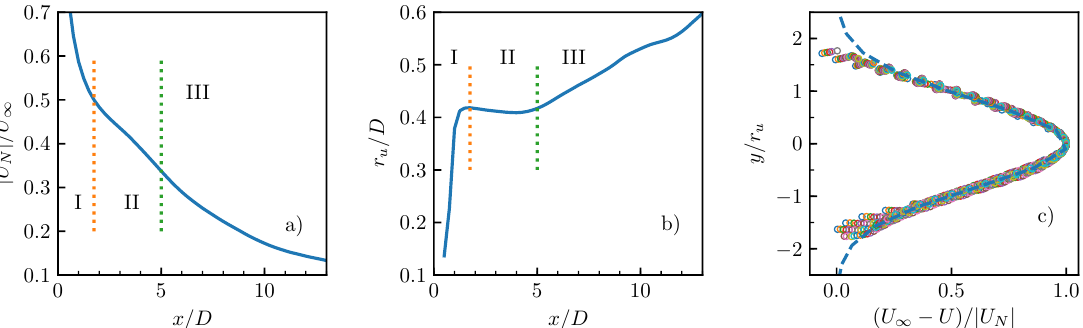
Figure 9. The self-similarity of the mean velocity deficit. The characteristic scales of velocity deficit and wake width are shown in ( a , b ), respectively, where the dotted lines are the boundaries of the three stages of wake development. The normalized spanwise profile of mean velocity deficit at the stages II and III are plotted with circular points in ( c ) and the dashed line is a Gaussian distribution fitting for the normalized